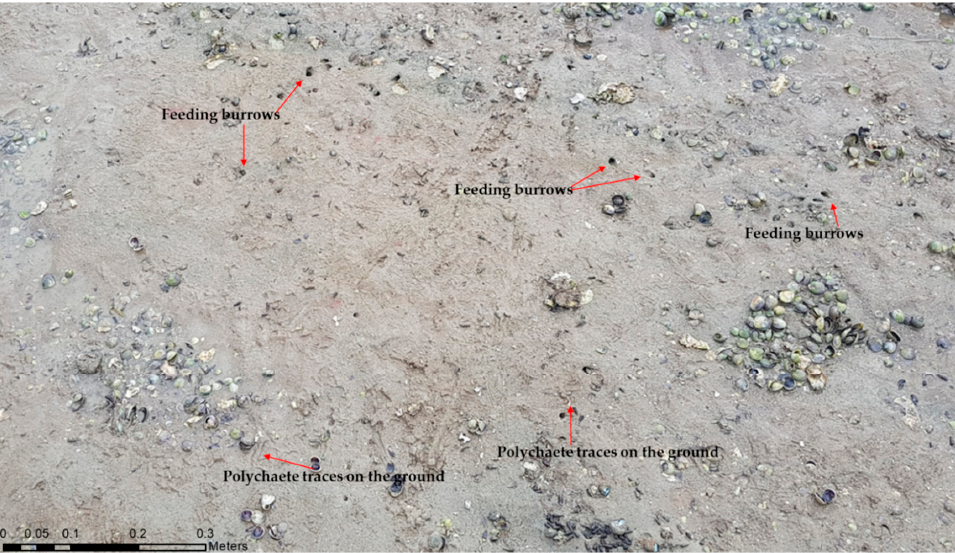
Figure 4. A ground truthing image shows macrofauna benthic activity from feeding burrows and traces of polychaetes crawling in the sediment.